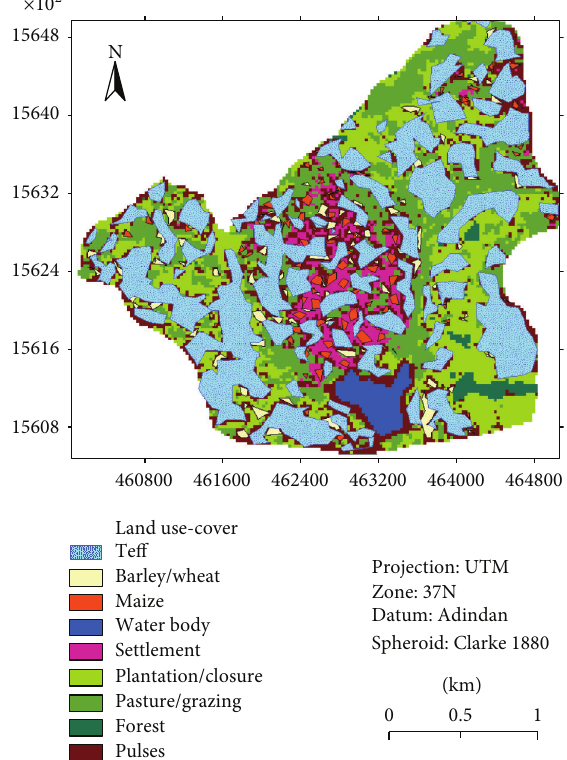
Figure 3: Land use and land cover of the study